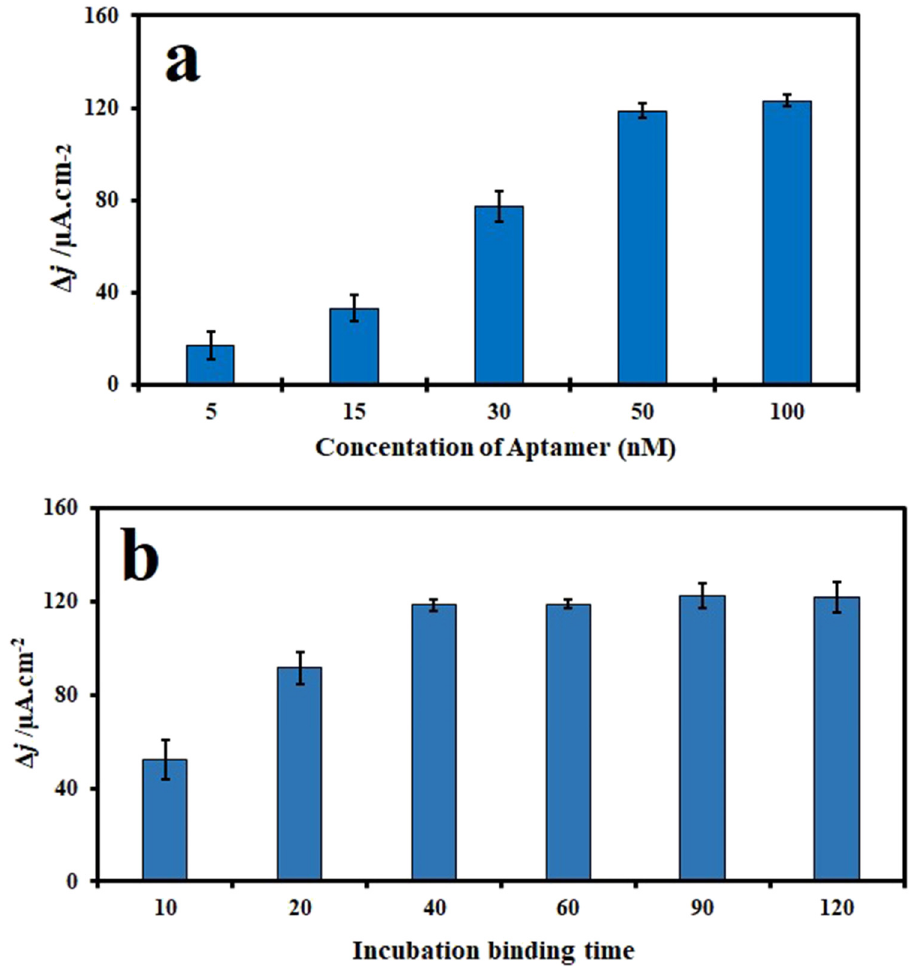
Figure 6: ( a ) Aptamer concentration and ( b ) incubation binding time in the presence of 5.0 × 10 4 cells/mL SKBR3